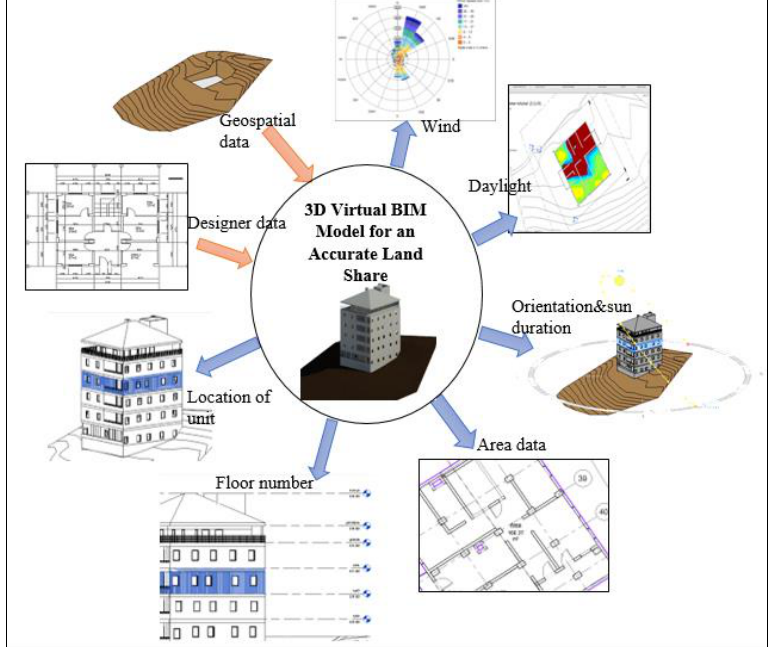
Figure 4. Land share factors defined with 3D BIM